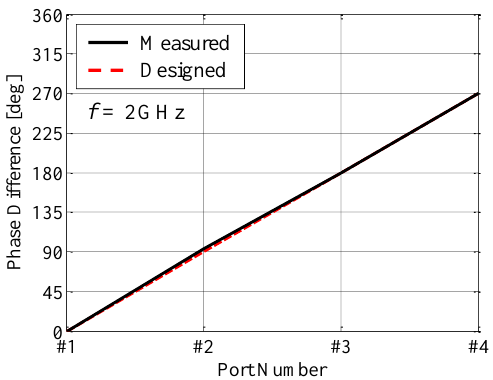
Figure 13. Phase characteristics of the fabricated AOA network.